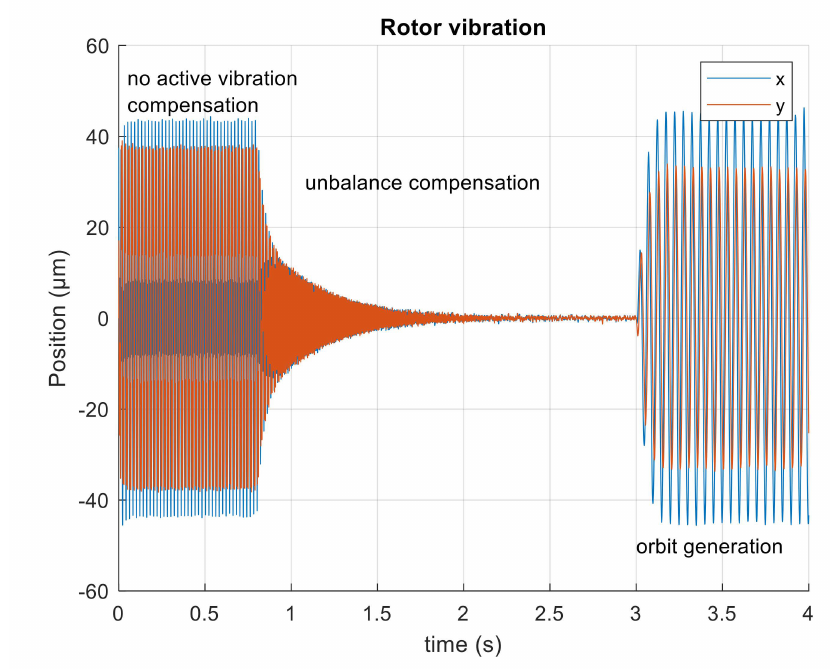
Figure 9. Simulated position of the rotor in axes, x and y .